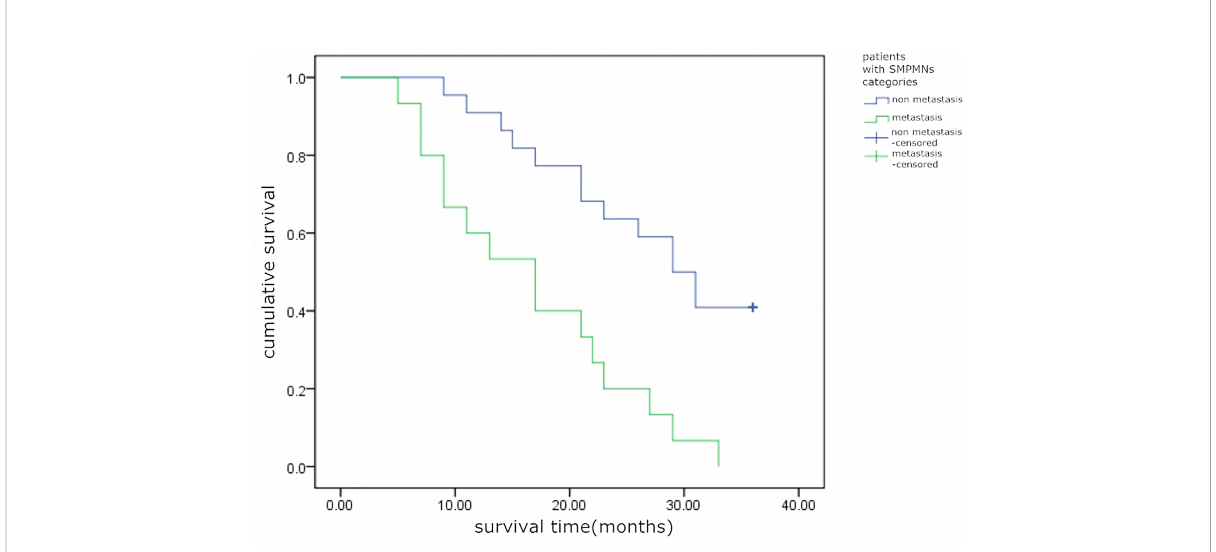
FIGURE 7 Kaplan – Meier survival analysis, time to death (in months), for the two categories of patients with synchronous multiple primary malignant neoplasms (SMPMNs) (log-rank test, c 2 = 12.627, p =